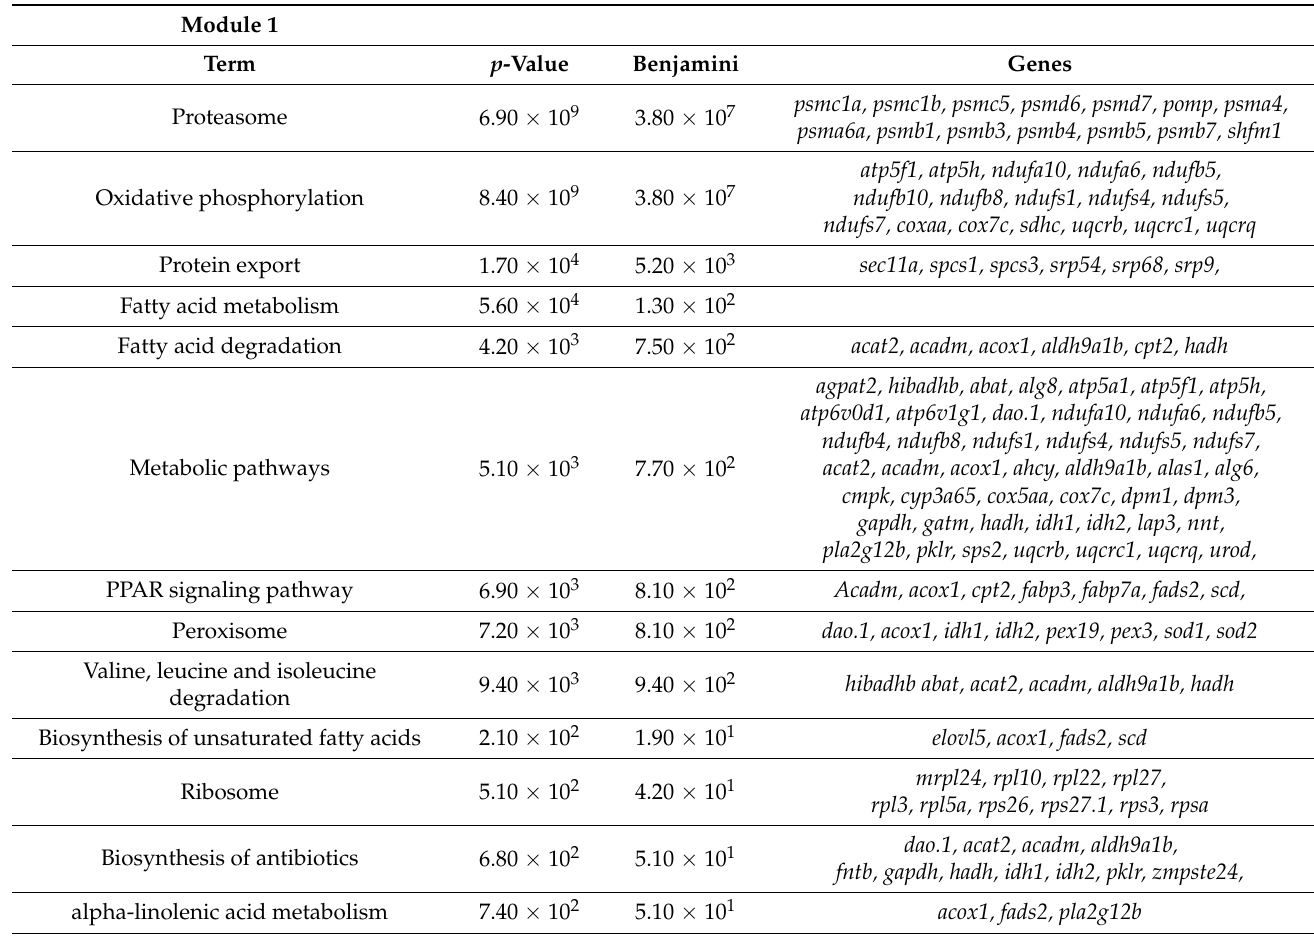
Table 6. KEGG pathways of DEGs from Module 1 and Module 2 from the COEX network in the liver of zebrafish affected by starvation.